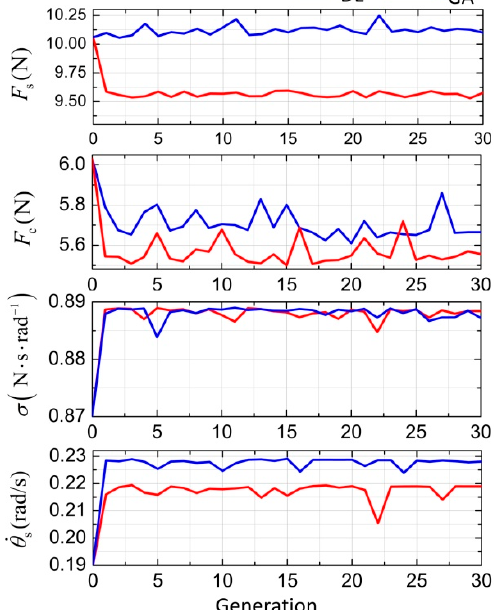
d k in the position tracking experiment.